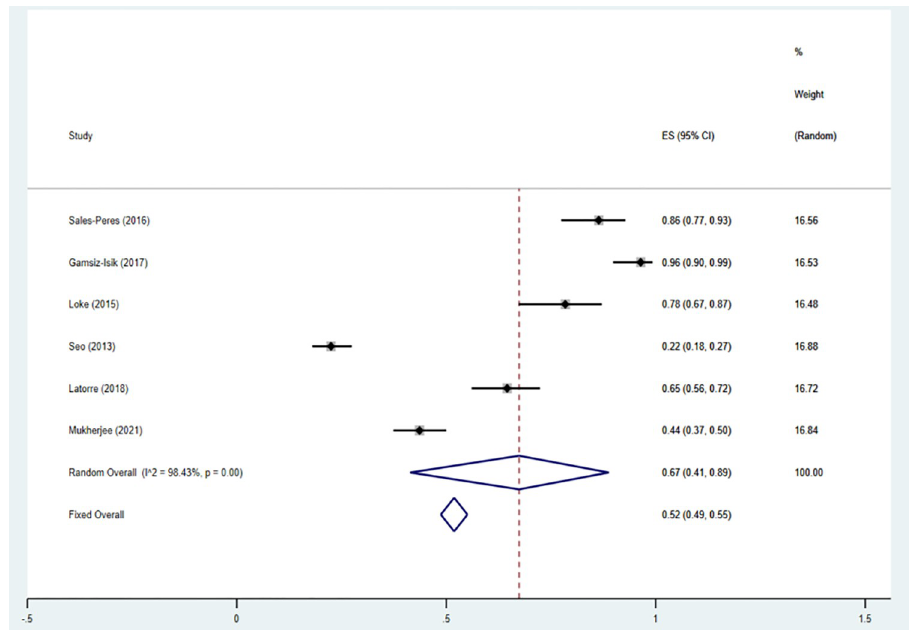
Fig 3. Forest plot of the incidence of periodontitis in OSA according to the results of six studies.